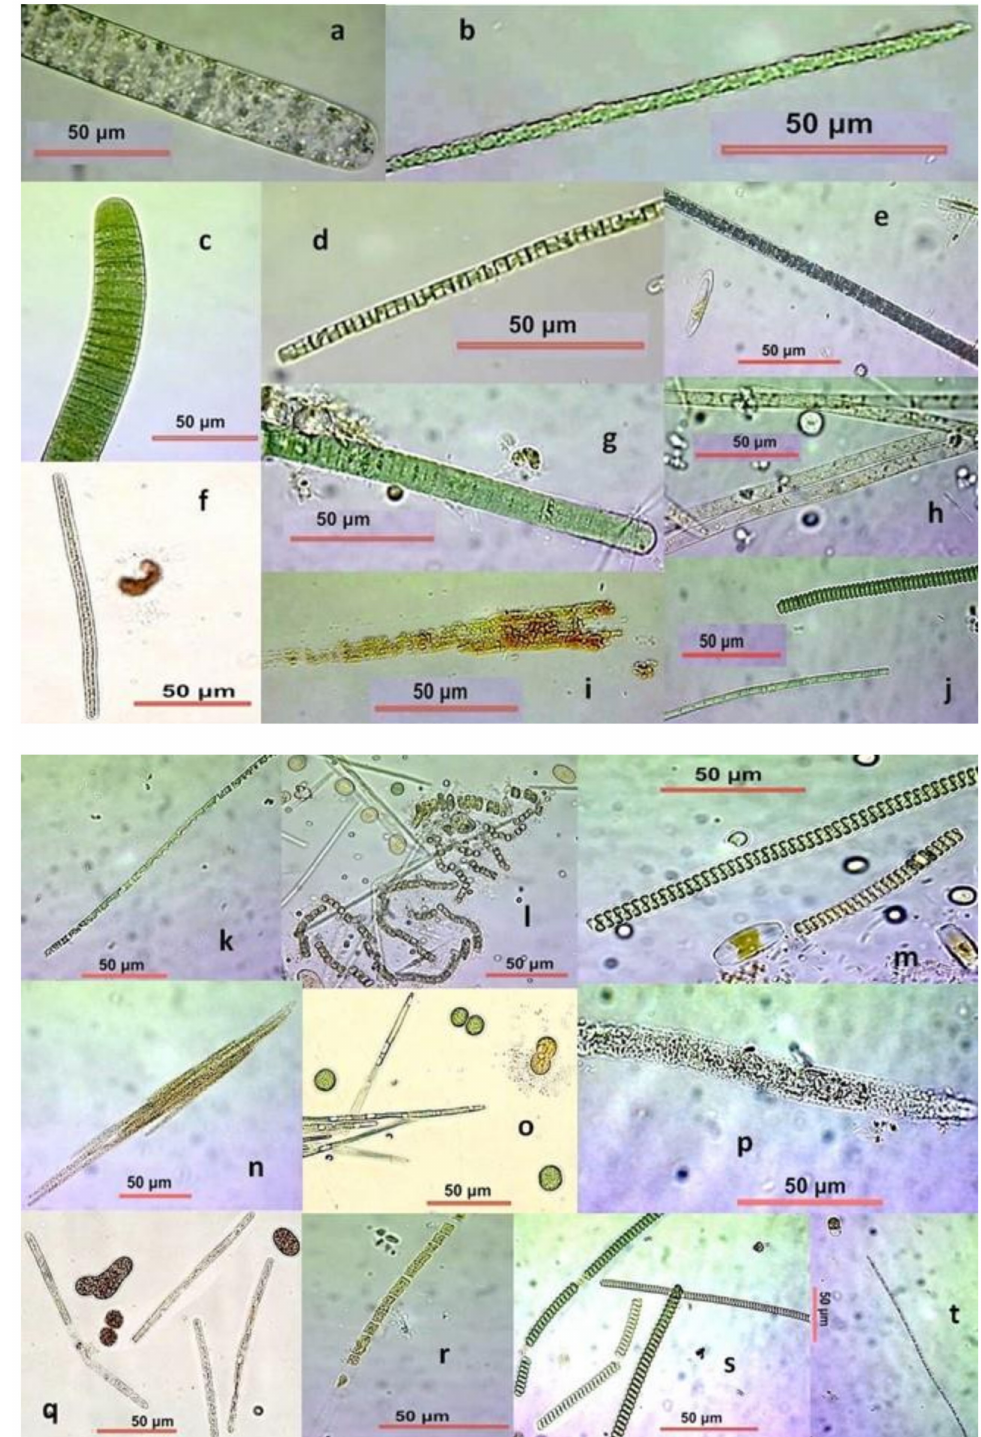
Figure 2. Filamentous Cyanobacteria from hypersalinity ponds. ( a ) Oscillatoria sp.; ( b ) uniden- tified trichome; ( c ) Oscillatoria sp.; ( d ) unidentified trichome; ( e ) Beggiatoa sp.?; ( f ) unidentified; ( g ) Lyngbya sp.; ( h ) Tychonema sp.; ( i ) Aphanizomenon sp.; ( j ) Pseudoanabaena sp.? and Arthrospira sp.; ( k ) Prochlorothrix sp.; ( l ) Anabaena sp.; ( m ) Arthrospira sp. thick and thin filaments; ( n ) Aphani- zomenon sp.; ( o ) Prochlorothrix sp.?; ( p ) Cylindrospermopsis sp.?; ( q ) Beggiatoa sp. among Synechococcus ; ( r ) Cylindrospermopsis sp.; ( s ) fragmented Arthrospira filaments of various thickness; ( t ) Cylindrosper- mopsis